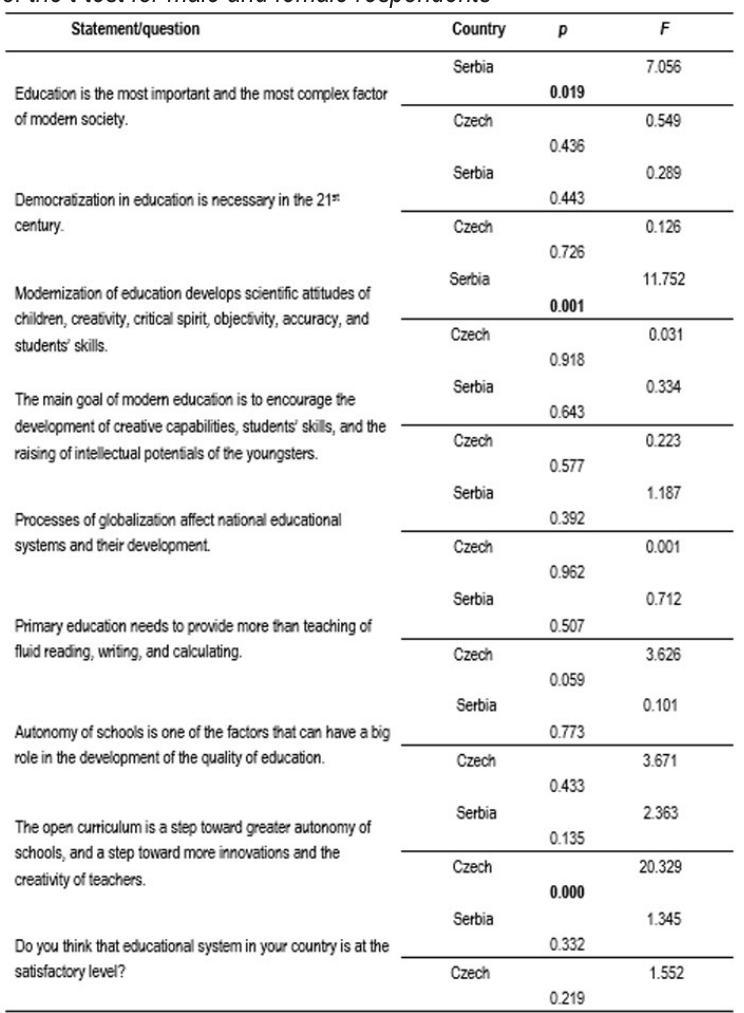
The results of the t-test for male and female